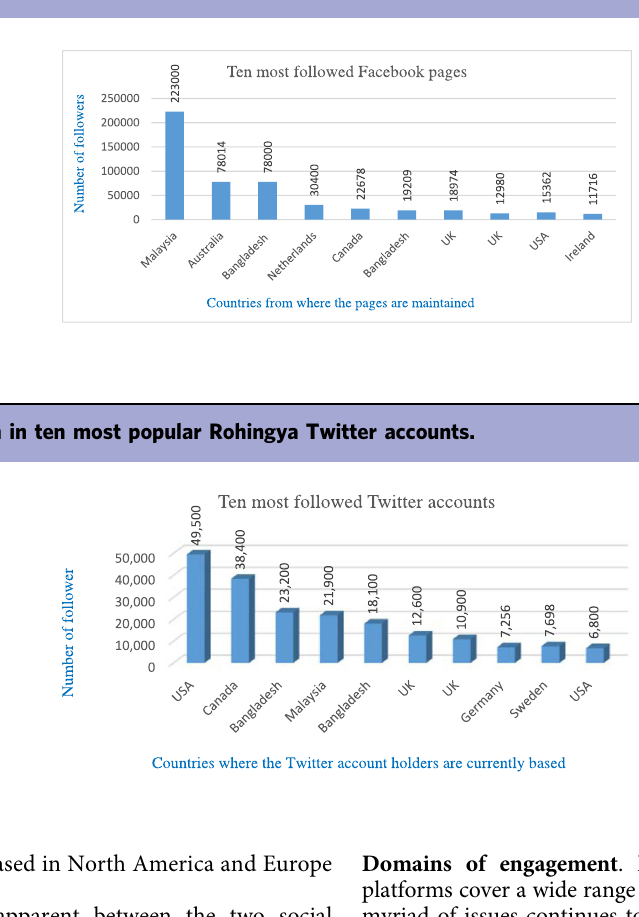
Table 1 Membership pattern in ten most popular Rohingya Facebook pages.